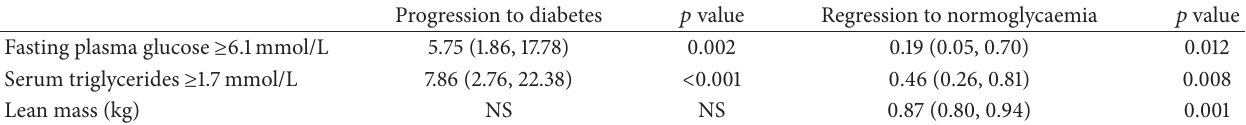
Metabolic syndrome excluding FPG. Table3: Oddsratiosforindependentpredictorsfromthelogisticregressionforprogressionfromimpairedfastingglucose(IFG)atbaselineto diabetes or regression to normoglycaemia over a 10-year follow-up period in women. Of 181 women, 21 developed diabetes over the follow-up period and 104 reverted to normoglycaemia. Data are presented as OR (95%